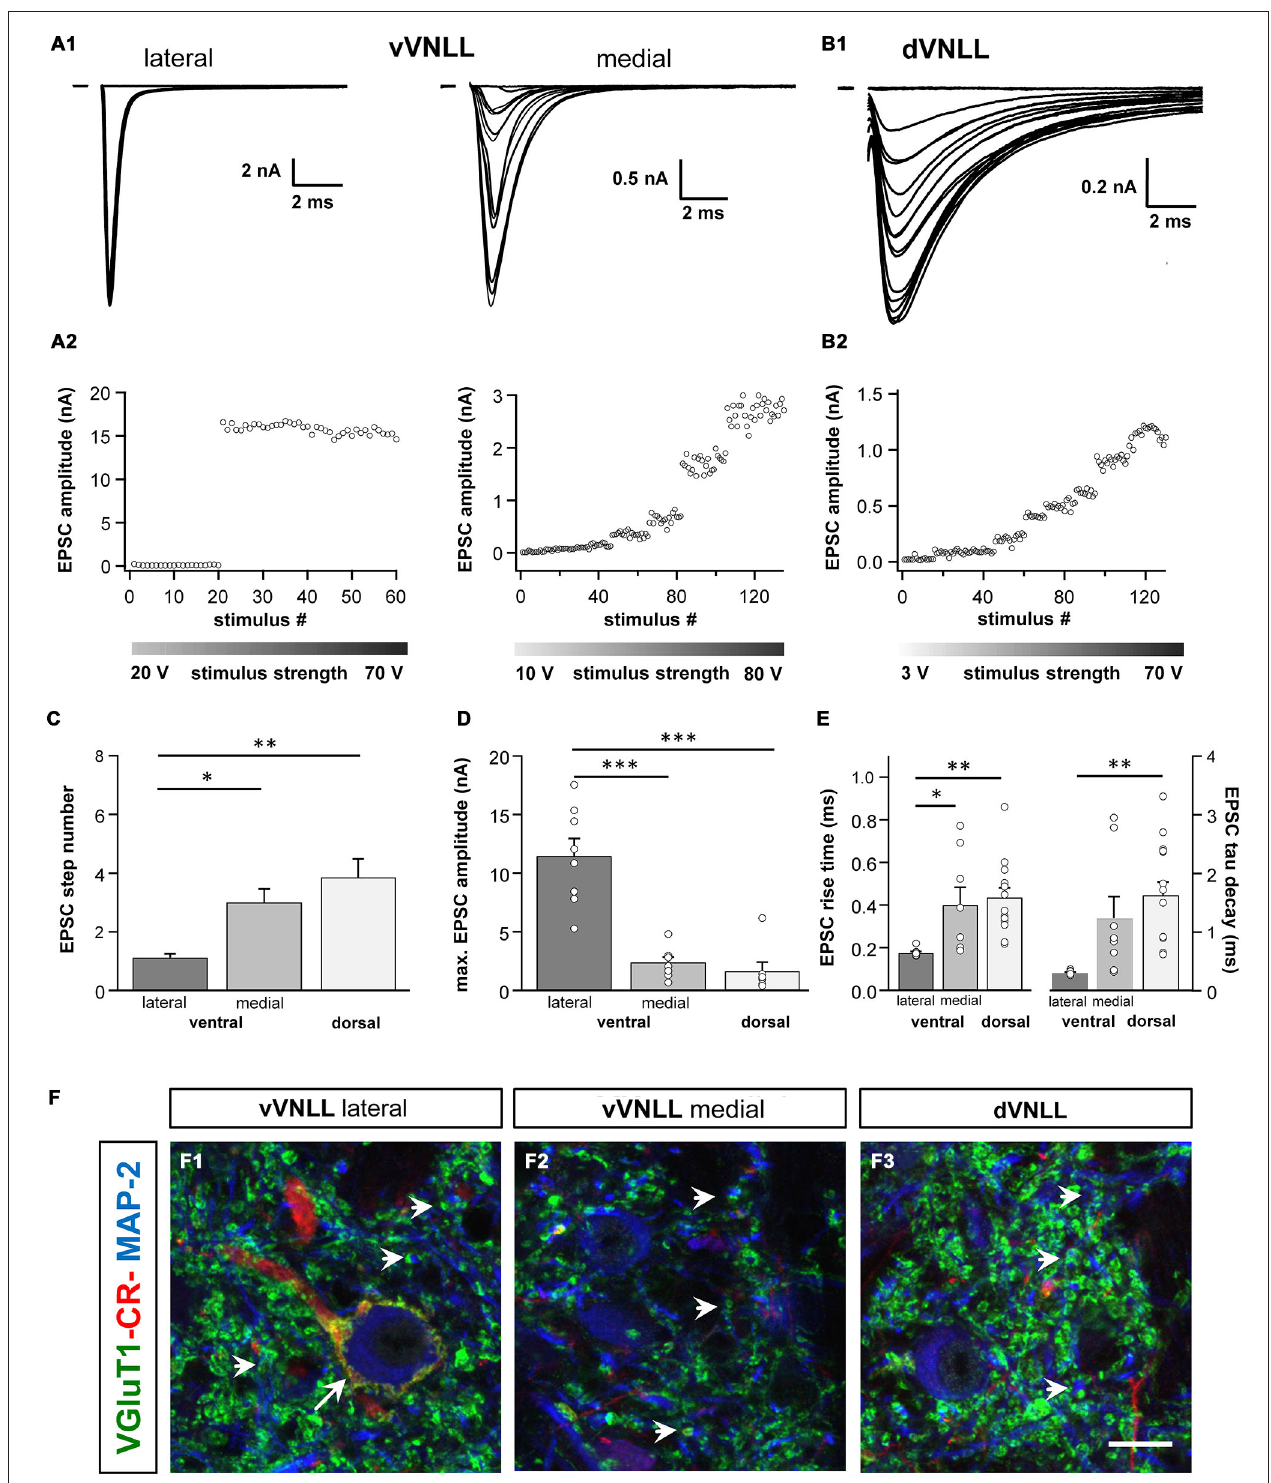
FIGURE 4 | Excitatory postsynaptic currents (EPSCs) are larger and the excitatory inputs are stronger in vVNLL neurons. (A1) Representative EPSC traces of ventrolateral (left) and ventromedial (right) VNLL neurons. Responses were evoked by increasing stimulation strength. One strong input was found in most ventrolateral neurons, whereas medial neurons showed multiple inputs. All traces represent the average of at least three consecutive recordings to the same stimulus strength. (A2) EPSC amplitude as a function of stimulus number recorded from ventrolateral and ventromedial vVNLL neurons shown in (A1) . (B1)